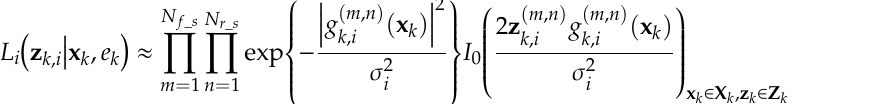
Figure 14. Comparison results of RMS errors: ( a ) RMS error of position; ( b ) RMS error of velocity.